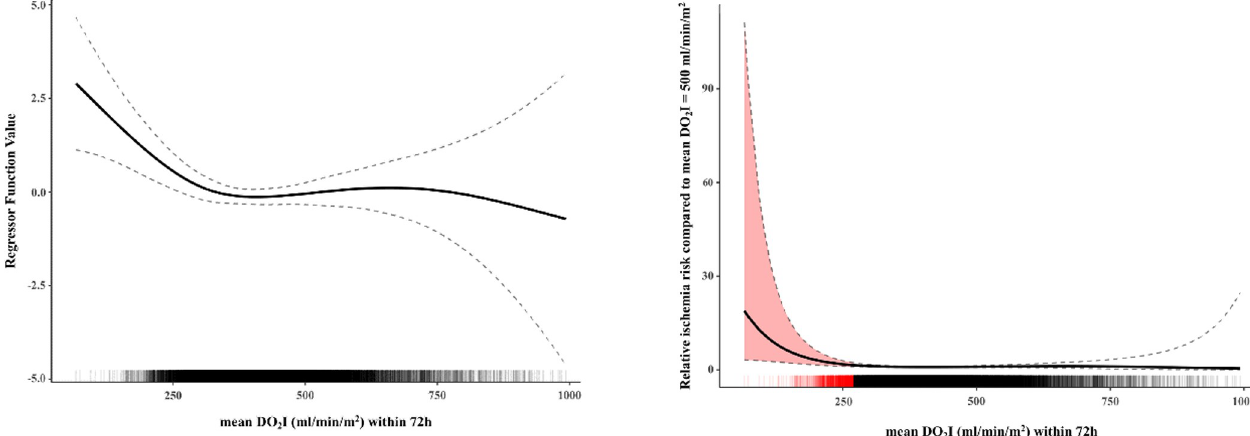
Fig 2. A. Regressor plot of meanDO 2 I within 72h. DO 2 I = oxygen delivery index, h = hour, the solid line shows the regressor plot for meanDO 2 I, dashed lines show the standard deviation, above the x-axis the 14.320 DO 2 I calculations are plotted as single small lines. B. Relative ischemia risk compared to mean DO 2 I within 72h before the onset of intestinal ischemia. Y-axis shows increasing relative ischemia risk with decreasing meanDO 2 I values (x-axis, solid line) by DO 2 I values below approximately 250ml/min/m 2 (highlighted by the red marked area), dashed lines show the standard deviation, above the x-axis the 14.320 DO 2 I calculations are plotted as single small lines (critical DO 2 I values are highlighted as a red line), DO 2 I = oxygen delivery index, h = hours.